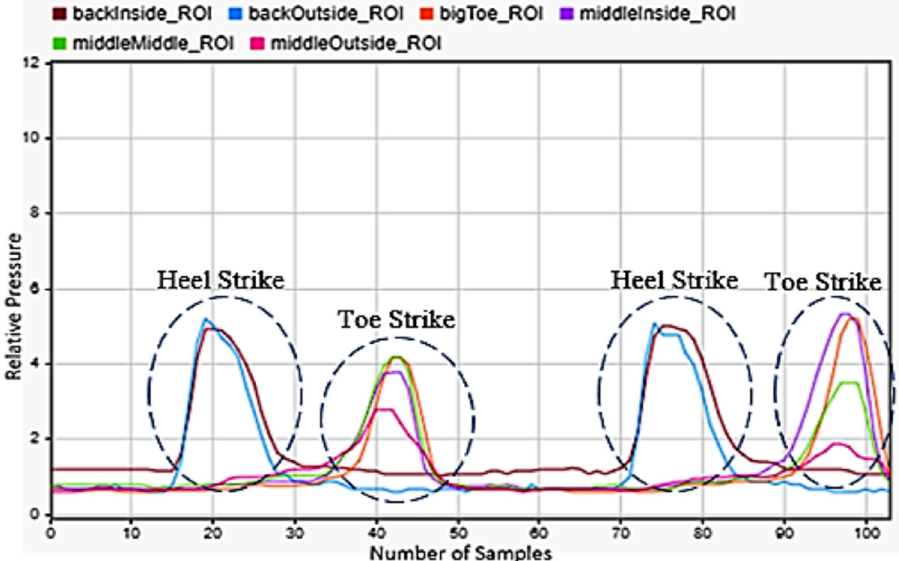
Figure 4. Walking motion sensor readings for the left foot.